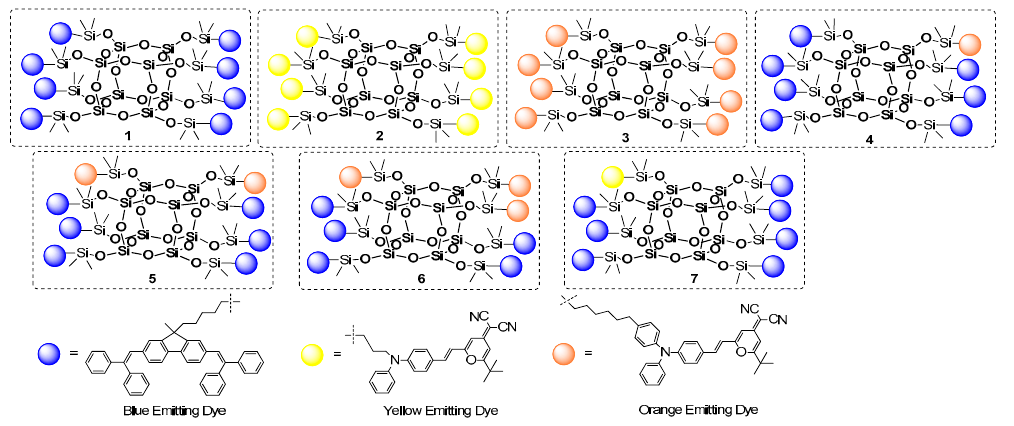
Figure 27. Synthetic hydrosilylation route to T 8 -based systems with mixed organic fluorescent emitters.